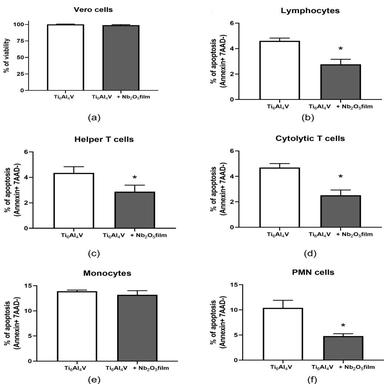
Effect of coated and uncoated biomaterial in VERO cell viability and Human Leukocytes blood apoptosis. (a) VERO-CCL-81 cell line, (b) lymphocytes, (c) helper T cells, (d) cytolytic T cells, (e) monocytes, and (f) PMN cells. Bars represent the mean ± standard error from triplicate samples. \P ≤ 0.05 compared with uncoated Ti6Al4V alloy.